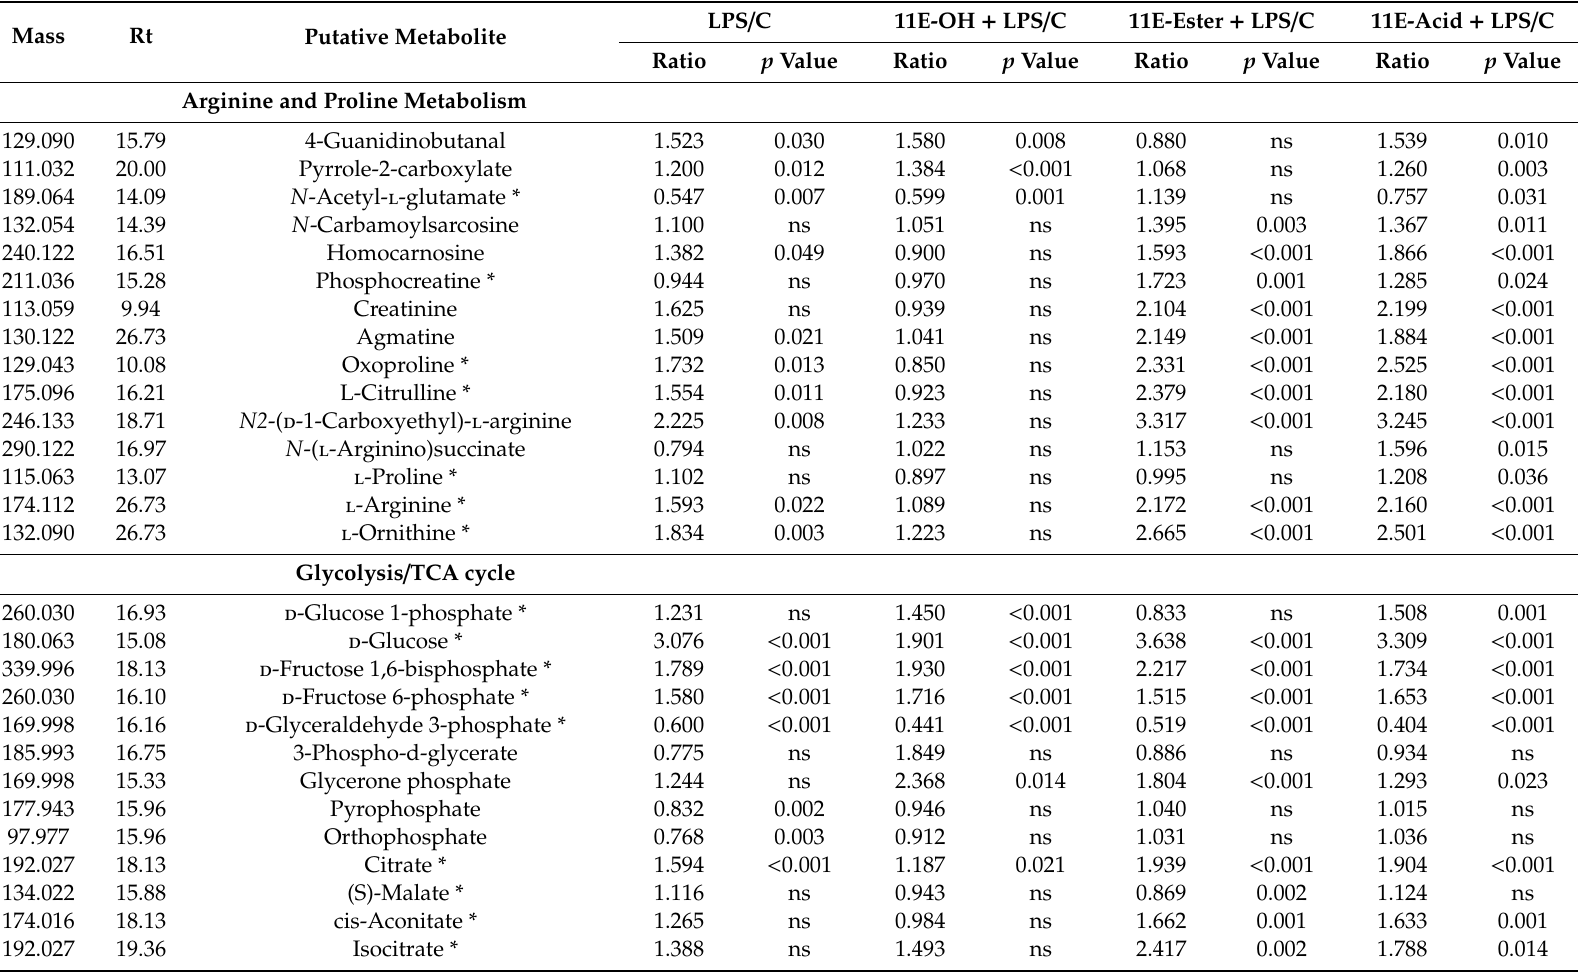
Table 2. Significantly changed polar metabolites in THP-1 cells treated with lipopolysaccharide (LPS), alone or in combination with one of three synthetic forms